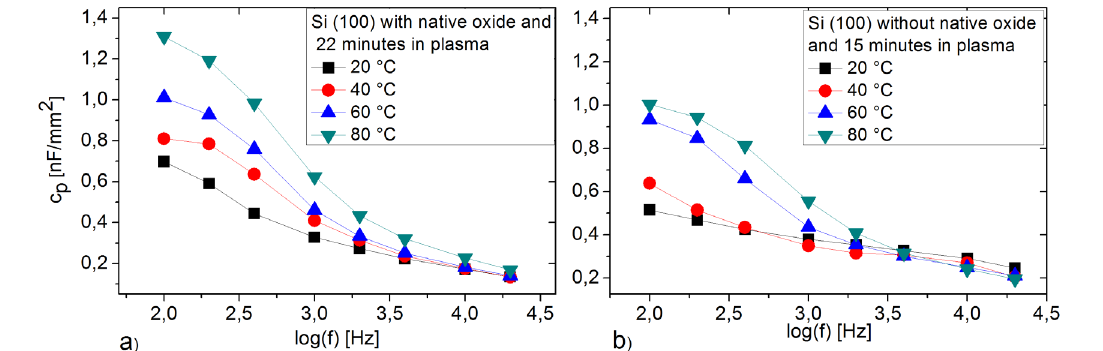
Figure 5 : Measured capacitance density of the samples vs. frequency for various temperatures: a) Plasma treated layer with the native oxide b) Plasma treated layer with HF